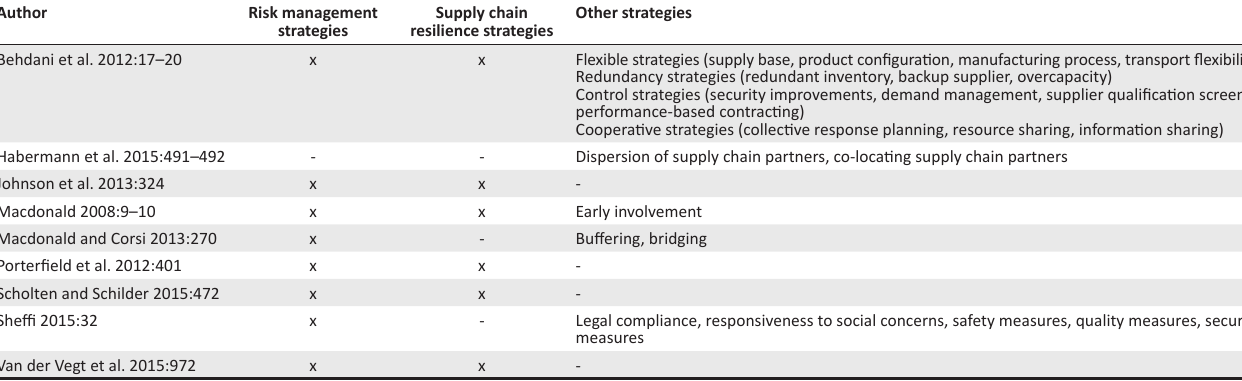
TABLE 3: Strategies to mitigate